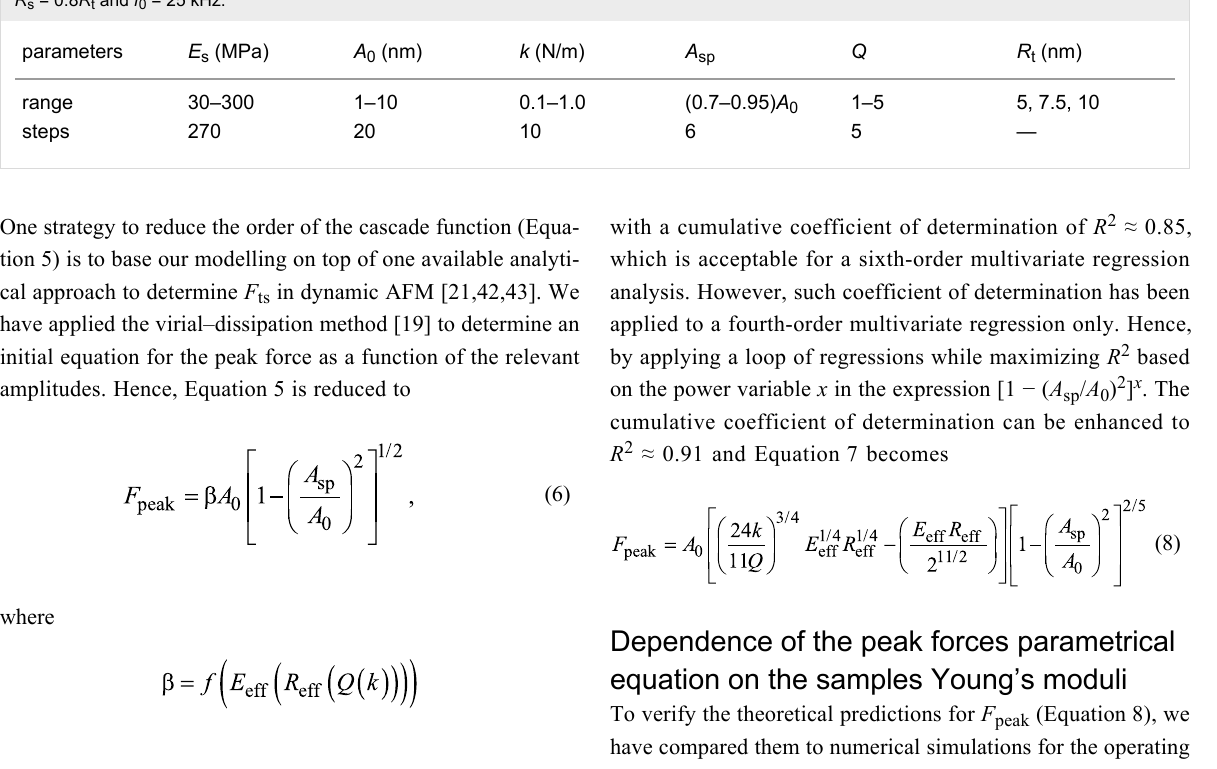
Table 1: Simulation parameters defined for the multivariate regression analysis. In all cases the values of the ratio between tip and sample are R s = 0.8 R t and f 0 = 25 kHz.